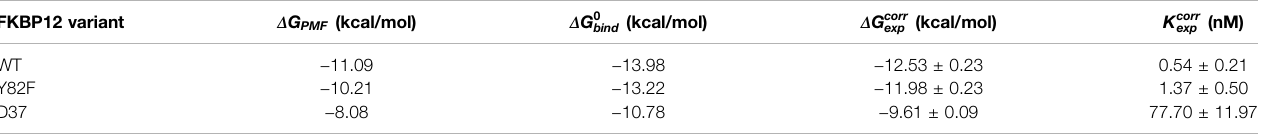
TABLE1| ComparisonbetweenthenumericallyandtheexperimentallydeterminedbindingfreeenergiesfortheFKBP12 + rapamycin % FKBP12 results, i.e., the PMF and the corrected standard free energies, Δ G PMF and Δ G 0 bind respectively, were obtained thanks to the CPUS approach. For each of the three variants, only the values corresponding to the lower-bound PMF pro fi les were selected (Joshi and Lin, 2019). Measurements are issued from a publication reporting on an inhibitionassayinwhichtherotamaseactivityofFKBP12wasspectroscopicallymonitoredusingsuccinyl-AlaLeuProPhe- para -nitroalinideasasubstrateand α -chimotrypsin digestionasadevelopmentreaction(DeCenzoetal.,1996b).Theseoriginaldatawereacquiredat15 ° C,andweextrapolatedthemat21.85 ° C,thetemperatureatwhich simulationswereperformed,soastoobtainthecorrectedbindingfreeenergiesandequilibriumconstants, Δ G corr exp and K corr exp respectively(see SupplementaryTableS2 and Supplementary Figure S8 for